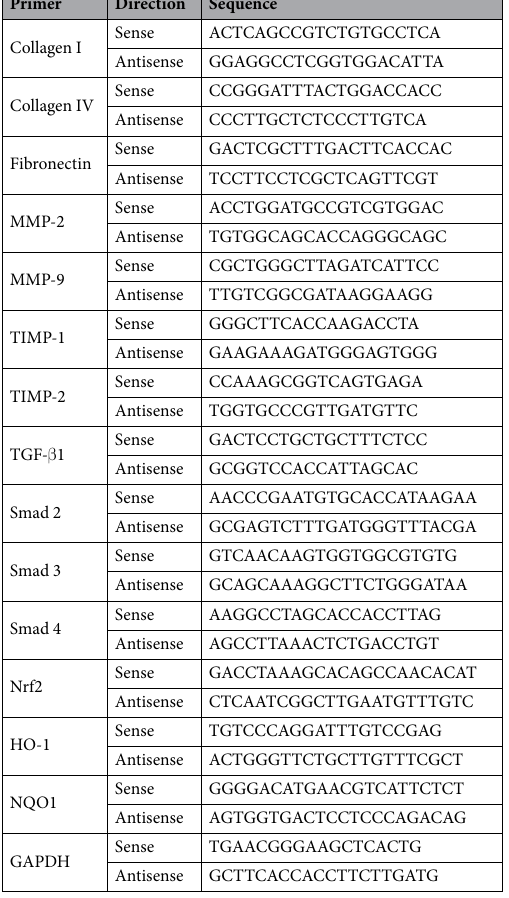
Table 1. Oligonucleotide primers sequences for mRNA